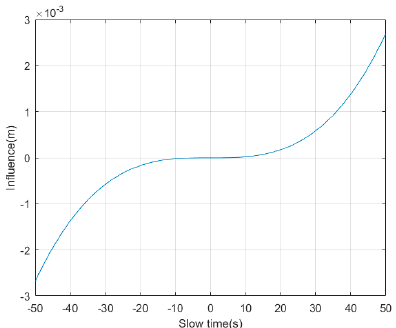
k of slant range. Figure A1. The influence of Target Motion on k 3 MT of slant 3 MT